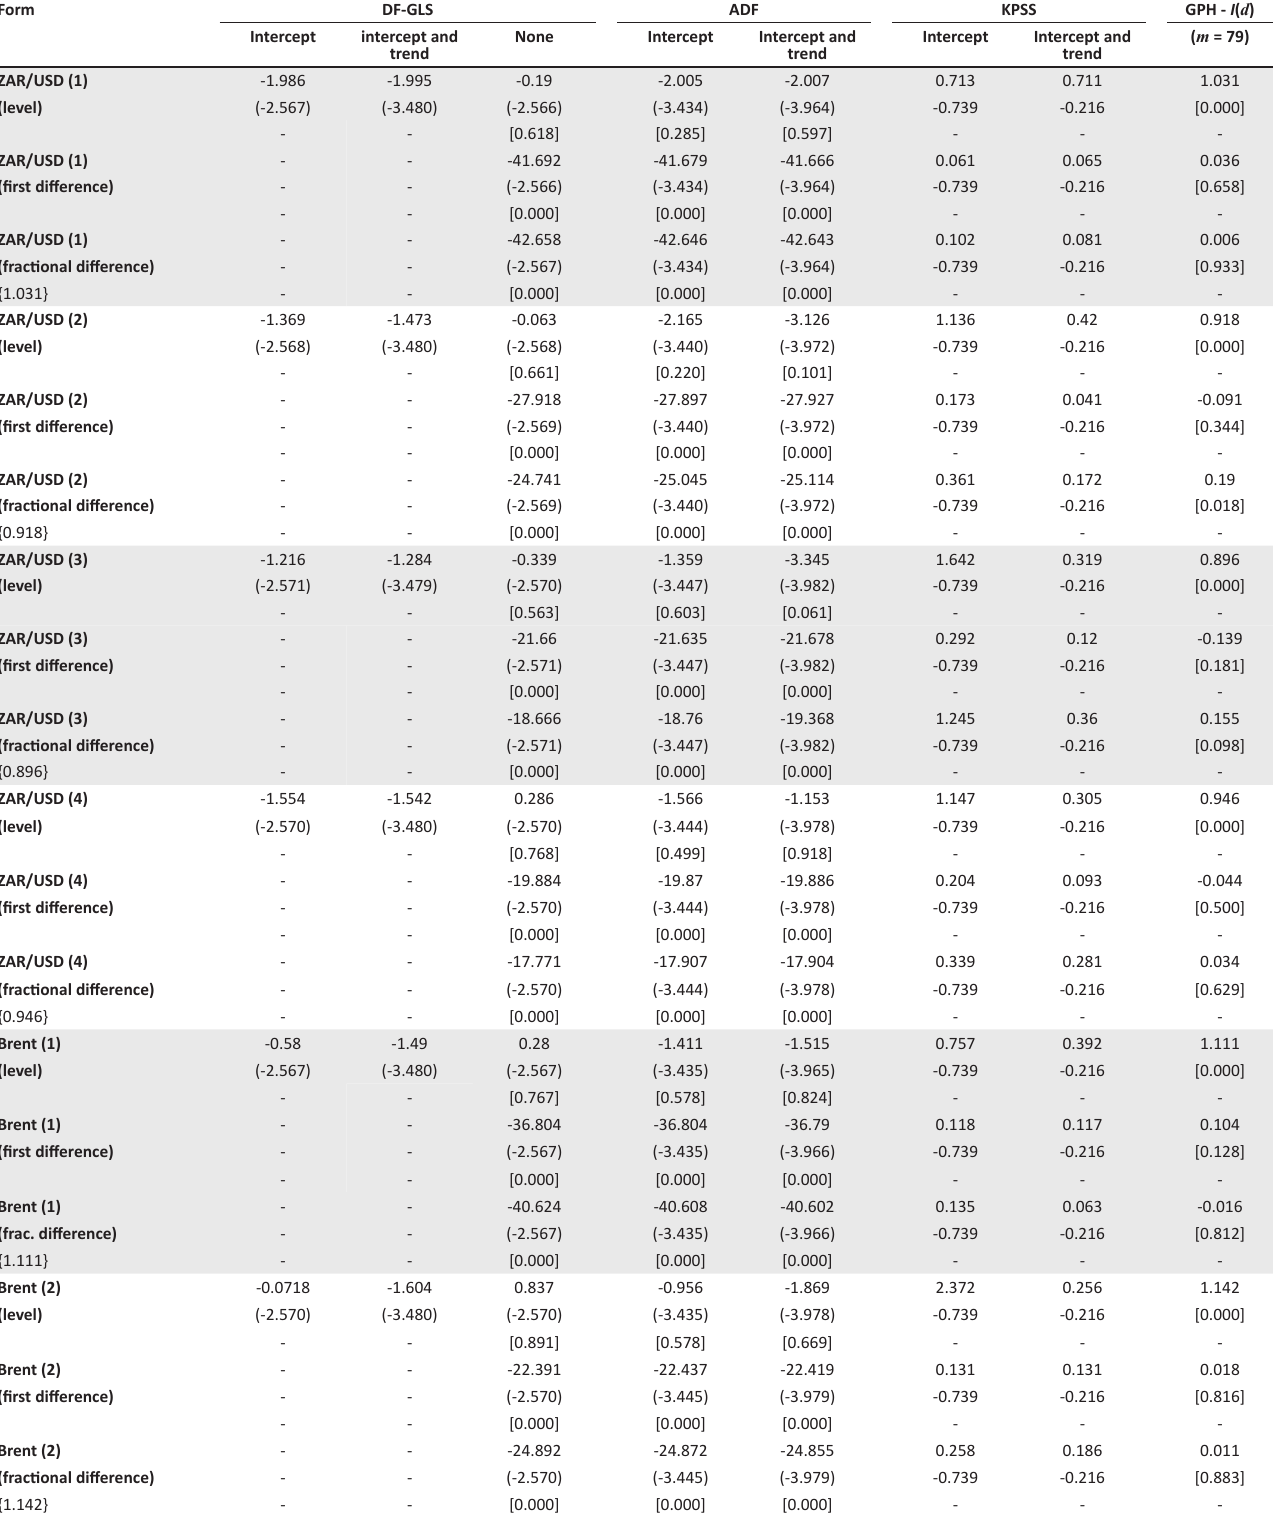
TABLE A1: Determining the correct form of stationarity. Form DF-GLS ADF KPSS GPH - I ( d ) Intercept intercept and None Intercept Intercept and Intercept Intercept and ( m = trend trend trend